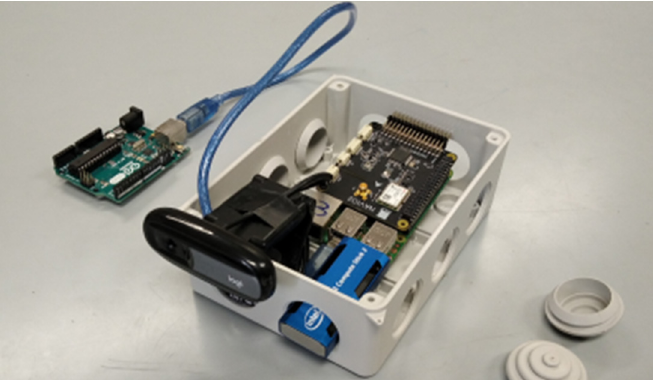
Figure 5. A typical high-level control components arrangement inside an IP55 plastic box, includ- ing a navio2 unit, a raspberry pi model 3B, an Intel NCS-2 module, and a USB camera. The connec- tion with indicative low-level components (here, an arduino uno unit, on the left) is also shown.